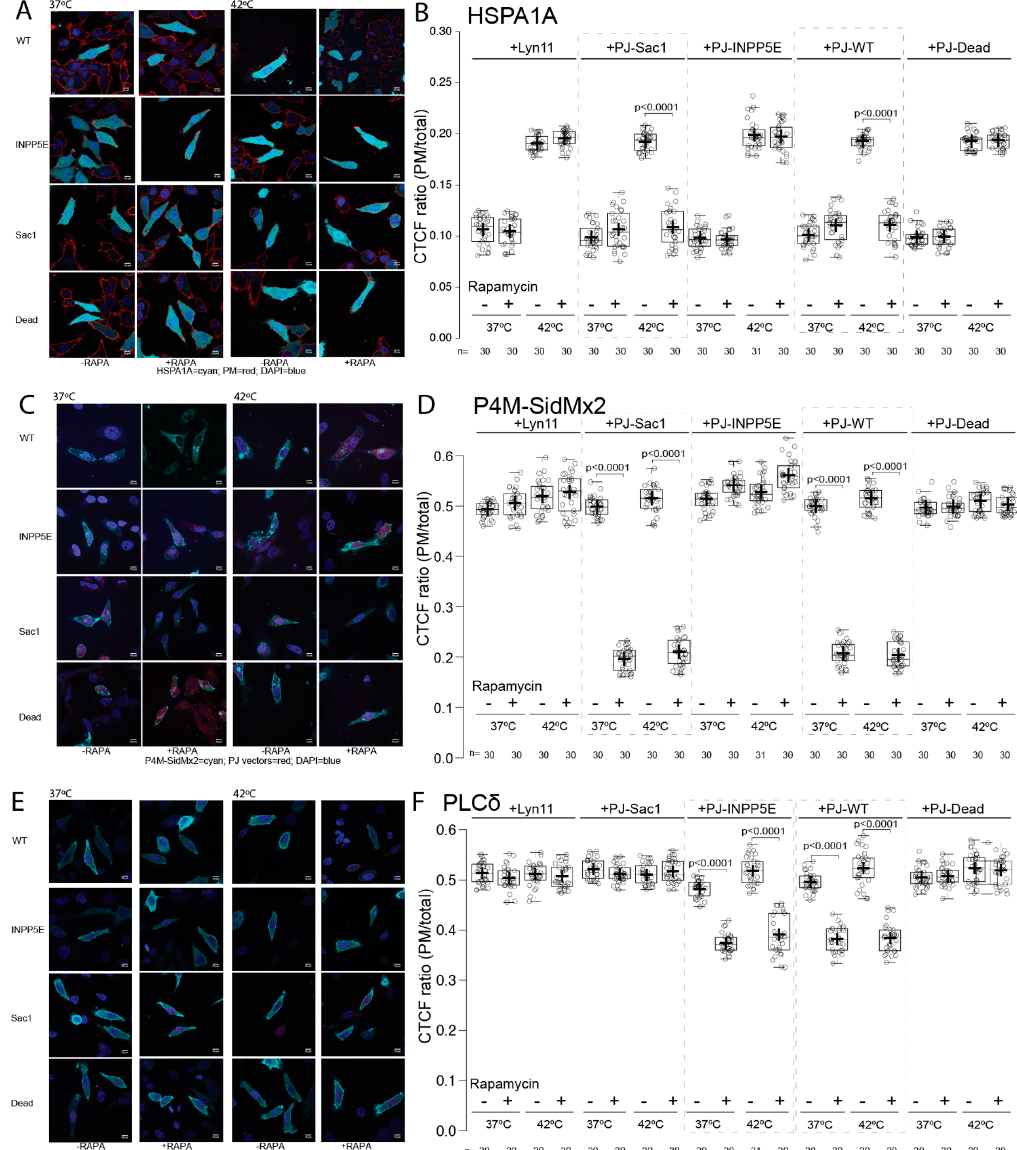
Figure 9. HSPA1A localization at the PM is decreased by the expression of Sac1 and WT enzymes. Representative images of HeLa cells expressing ( A ) GFP-HSPA1A, ( C ) GFP-P4M-SidMx2, and ( E ) GFP-PLC δ -PH with RFP-tagged PJ vectors and DAPI nucleus stain. The PM localization of HSPA1A was documented for all transfections at either control conditions (37 ◦ C; left columns) or heat-shocked conditions (1 h at 42 ◦ C/8 h at 37 ◦ C; right columns). Negative control cells contain either the vehicle alone (Lyn11) or the inactive vector (Dead). Scale bar = 10 µ M. ( B , D , F ) Quantification of the corrected total cell fluorescence (CTCF) as a ratio between the total GFP fluorescence of the protein of interest at the PM and the rest of the cell at control conditions and after heat shock with or without rapamycin treatment. The experiment was repeated three times, and the total number of cells (shown as open circles) per condition are shown at the bottom of the graph. The center lines show the medians; box limits indicate the 25th and 75th percentiles as determined by R software; whiskers extend 1.5 times the interquartile range from the 25th and 75th percentiles; crosses represent sample